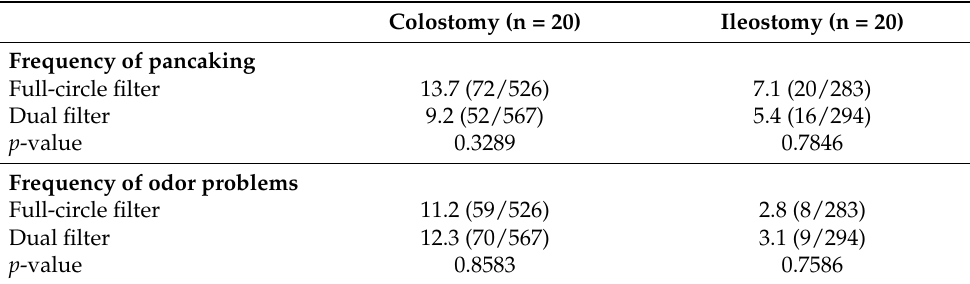
(number of bags with pancaking or odor problems/total number of